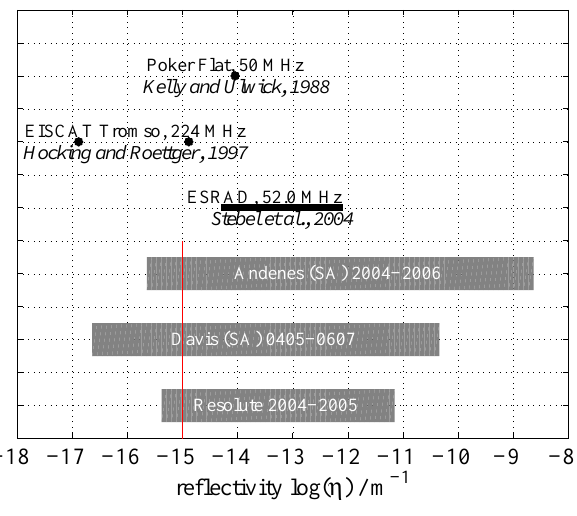
Fig. 6. Volume reflectivities detected by various VHF radars at dif- ferent sites (Kelley and Ulwick, 1988; Hocking and R¨ottger, 1997; Stebel et al., 2004). The red line indicates the lower threshold cho- sen for the comparison of occurrence